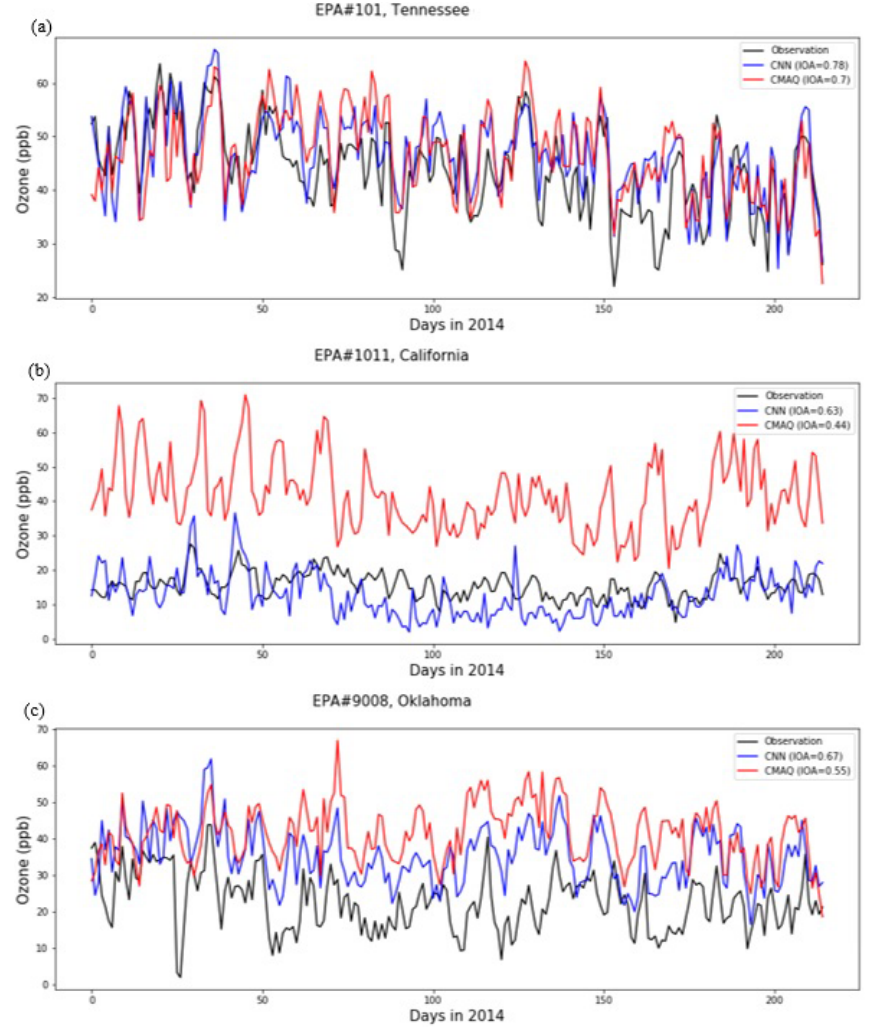
Figure 8. Comparison of the distance analysis of CMAQ and CMAQ-CNN predictions for EPA stations (a) no. 101 (Tennessee), (b) no. 1011 (California), and (c) no. 9008